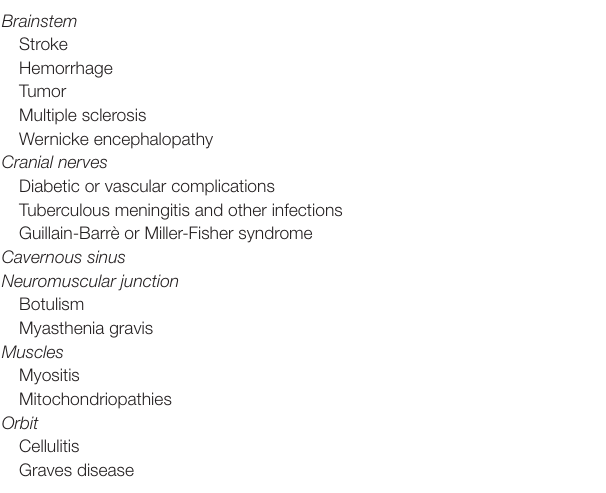
TABLE 1 | Causes of acute bilateral